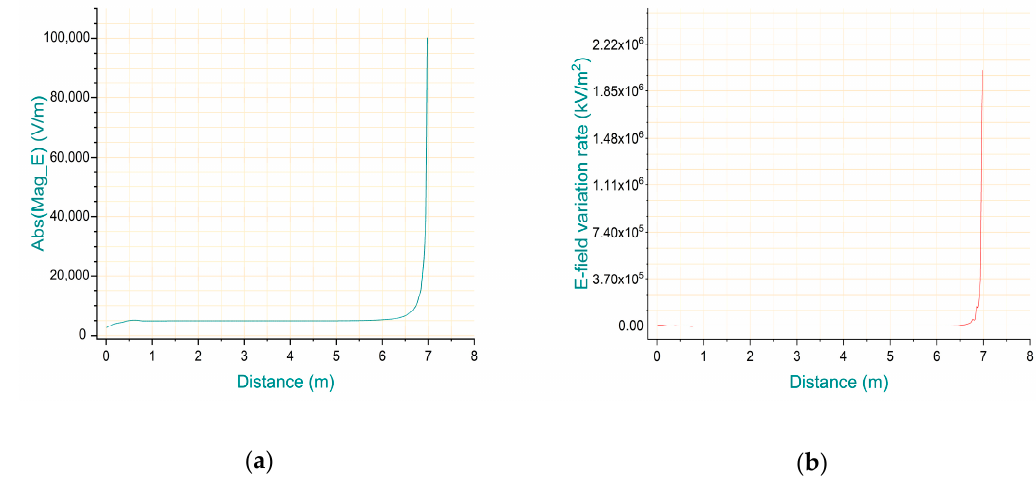
Figure 6. E-field information under 35 kV overhead line: ( a ) the distribution of E-field; ( b ) the E-field variation rate tendency.